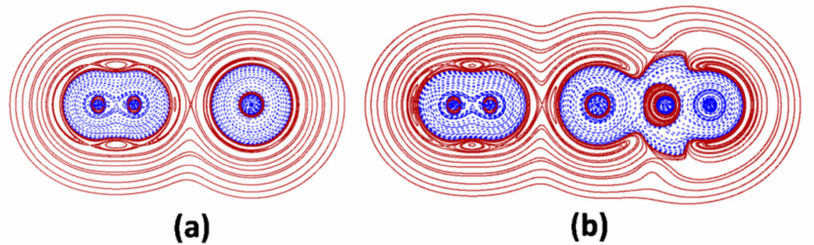
Figure 1. 2D-plots of H ( r ) in the main plane of ( a ) N 2 -Ar and ( b ) linear N 2 -ArBeO (solid/brown and dashed/blue lines correspond, respectively, to positive and negative